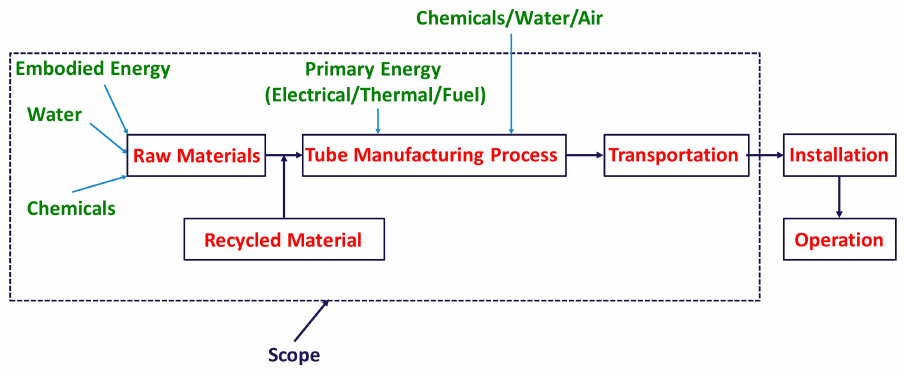
Figure 2. System boundary for tube manufacturing.